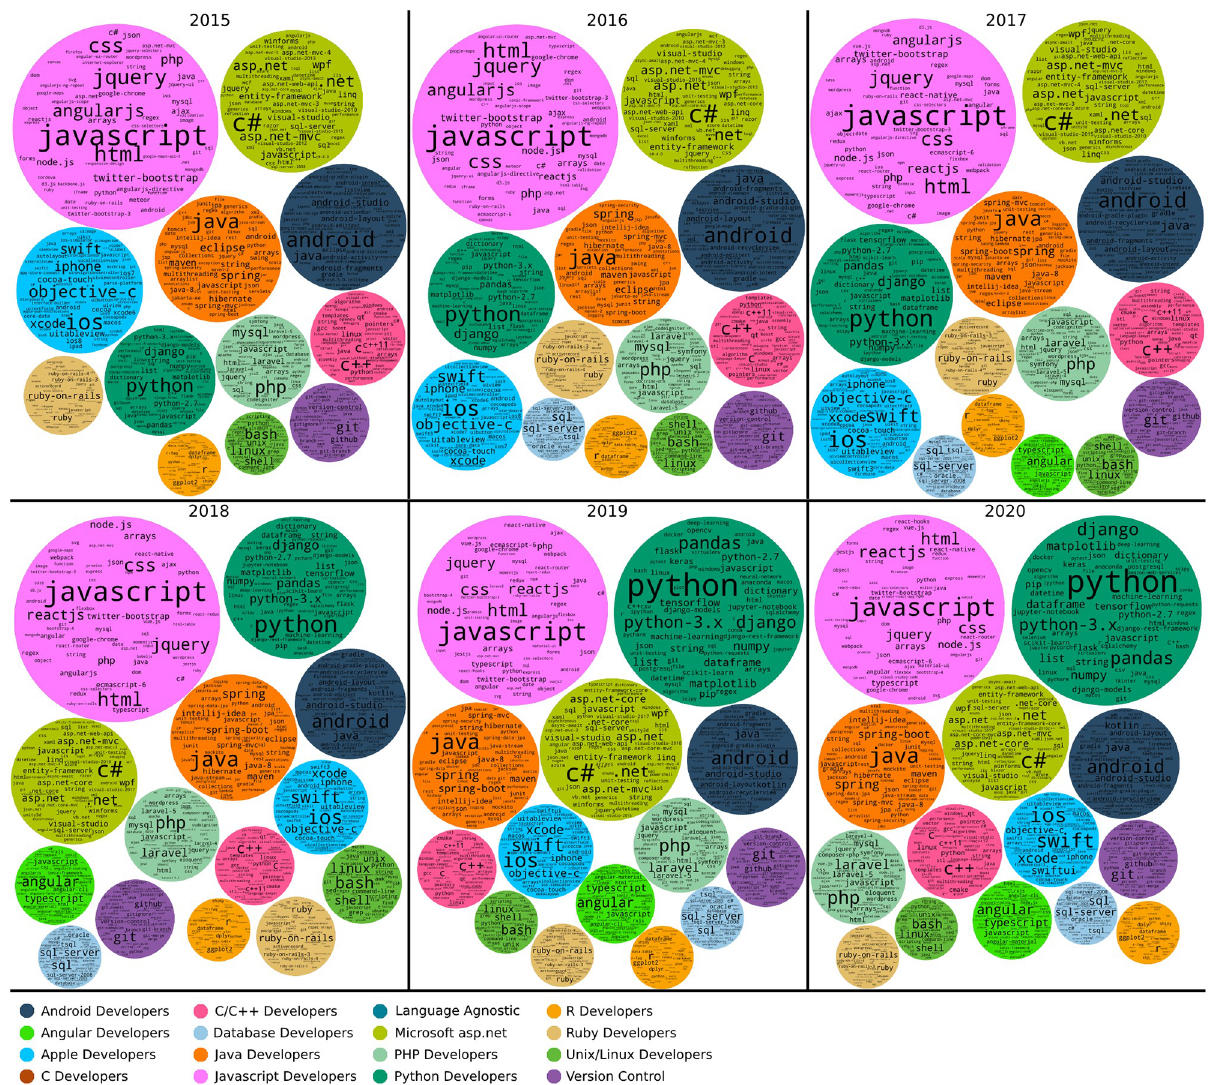
Fig 7. Evolution of the Stack Overflow communities from 2015 to 2020. Each circle shows a tag cloud with the most popular tags in a community identified in a given year. The size of the circles is somewhat proportional to the actual size of the communities, with some adjustments for layout.